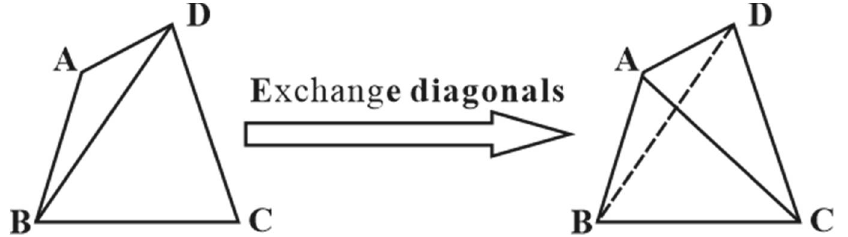
Figure 5. Maximum–minimum angle criterion: the minimum angle of two triangles is maximized by exchanging diagonal lines of quadrilaterals.